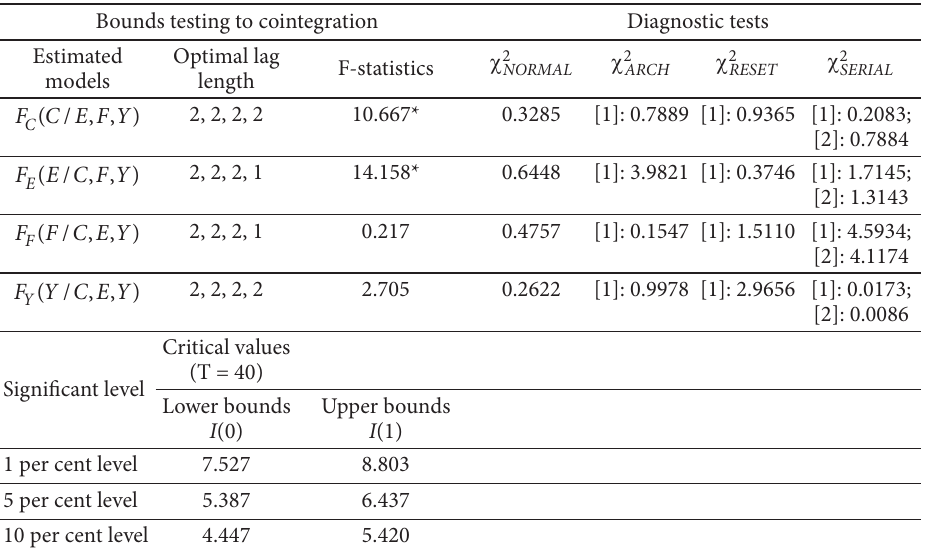
Table 3. The results of ARDL cointegration